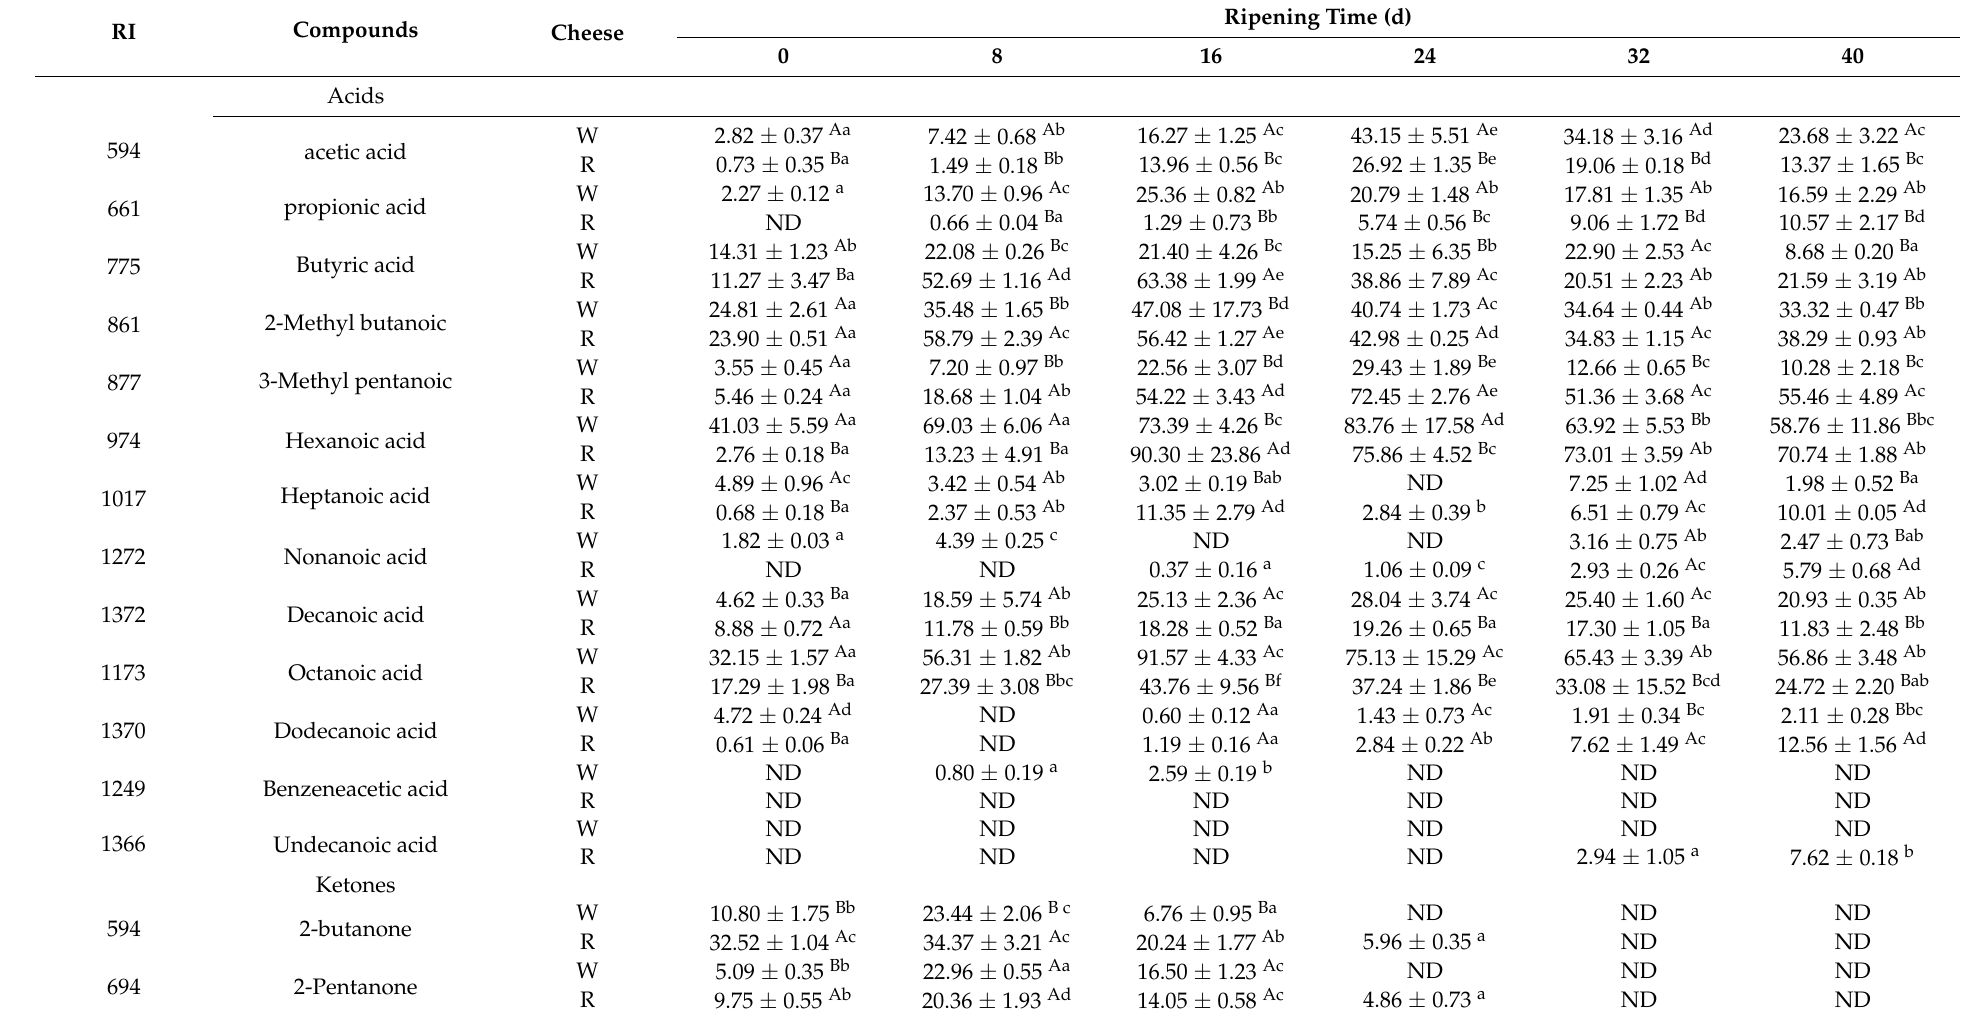
Table 1. Volatile compounds (ng/g) isolated from cheeses with different ripening